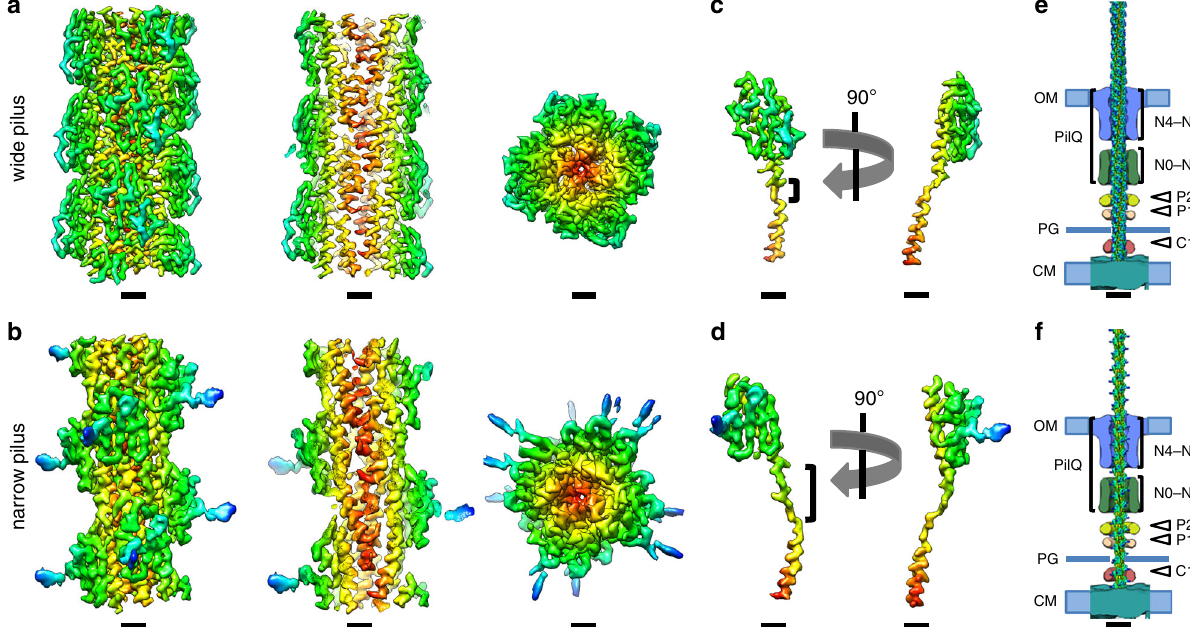
Fig. 2 Helical reconstruction of Thermus pili. a , b Side views, cross sections and top views of the density maps of wide ( a ) and narrow ( b ) pili, coloured by cylinder radius from red (centre) to blue (periphery). Scale bars, 10 Å. c , d Single subunits from wide ( c ) and narrow ( d ) pili segmented from the maps in a and b . The brackets show the melted stretch in the N-terminal α -helix. Scale bars, 10 Å. e , f Wide and narrow pili docked into the subtomogram average of the open state of the T4P machinery (EMD-3023) 11 . Domains of the secretin PilQ (blue and green; N0-N5), with unassigned protein densities P2 (yellow), P1 (orange) and C1 (red) are shown. OM outer membrane, PG peptidoglycan, CM cytoplasmic membrane. Scale bars, 10